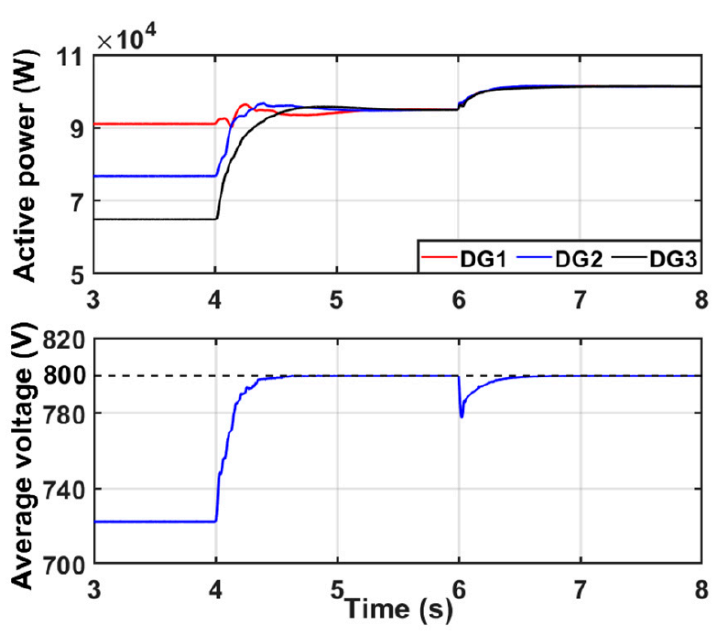
Figure 11. Simulation results in case of load variation under proposed algorithm.